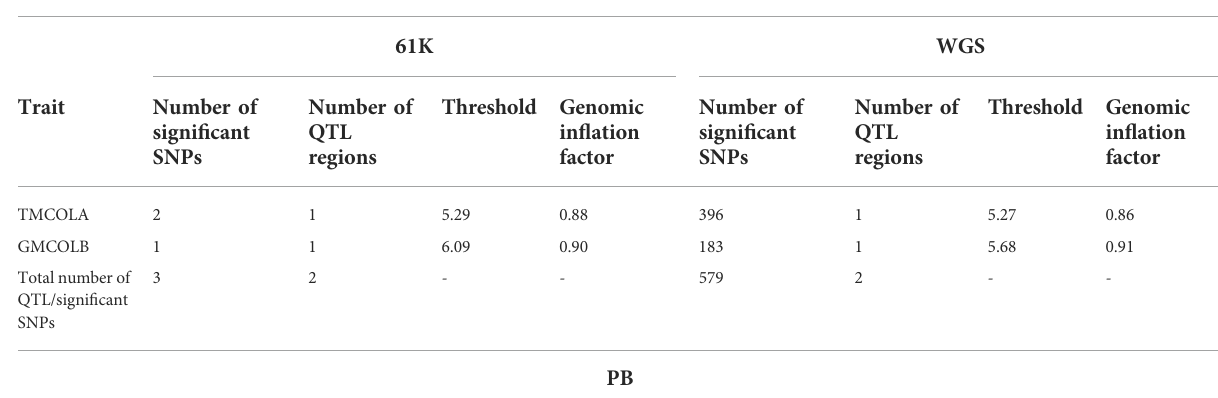
TABLE 7 Descriptive statistics of results of the GWAS for the pork colors with detected associated regions in at least one of the datasets at FDR > 0.1 (CBs, PBs, Combined dataset) using different SNP densities and imputed whole-genome sequence (WGS). CB 61K